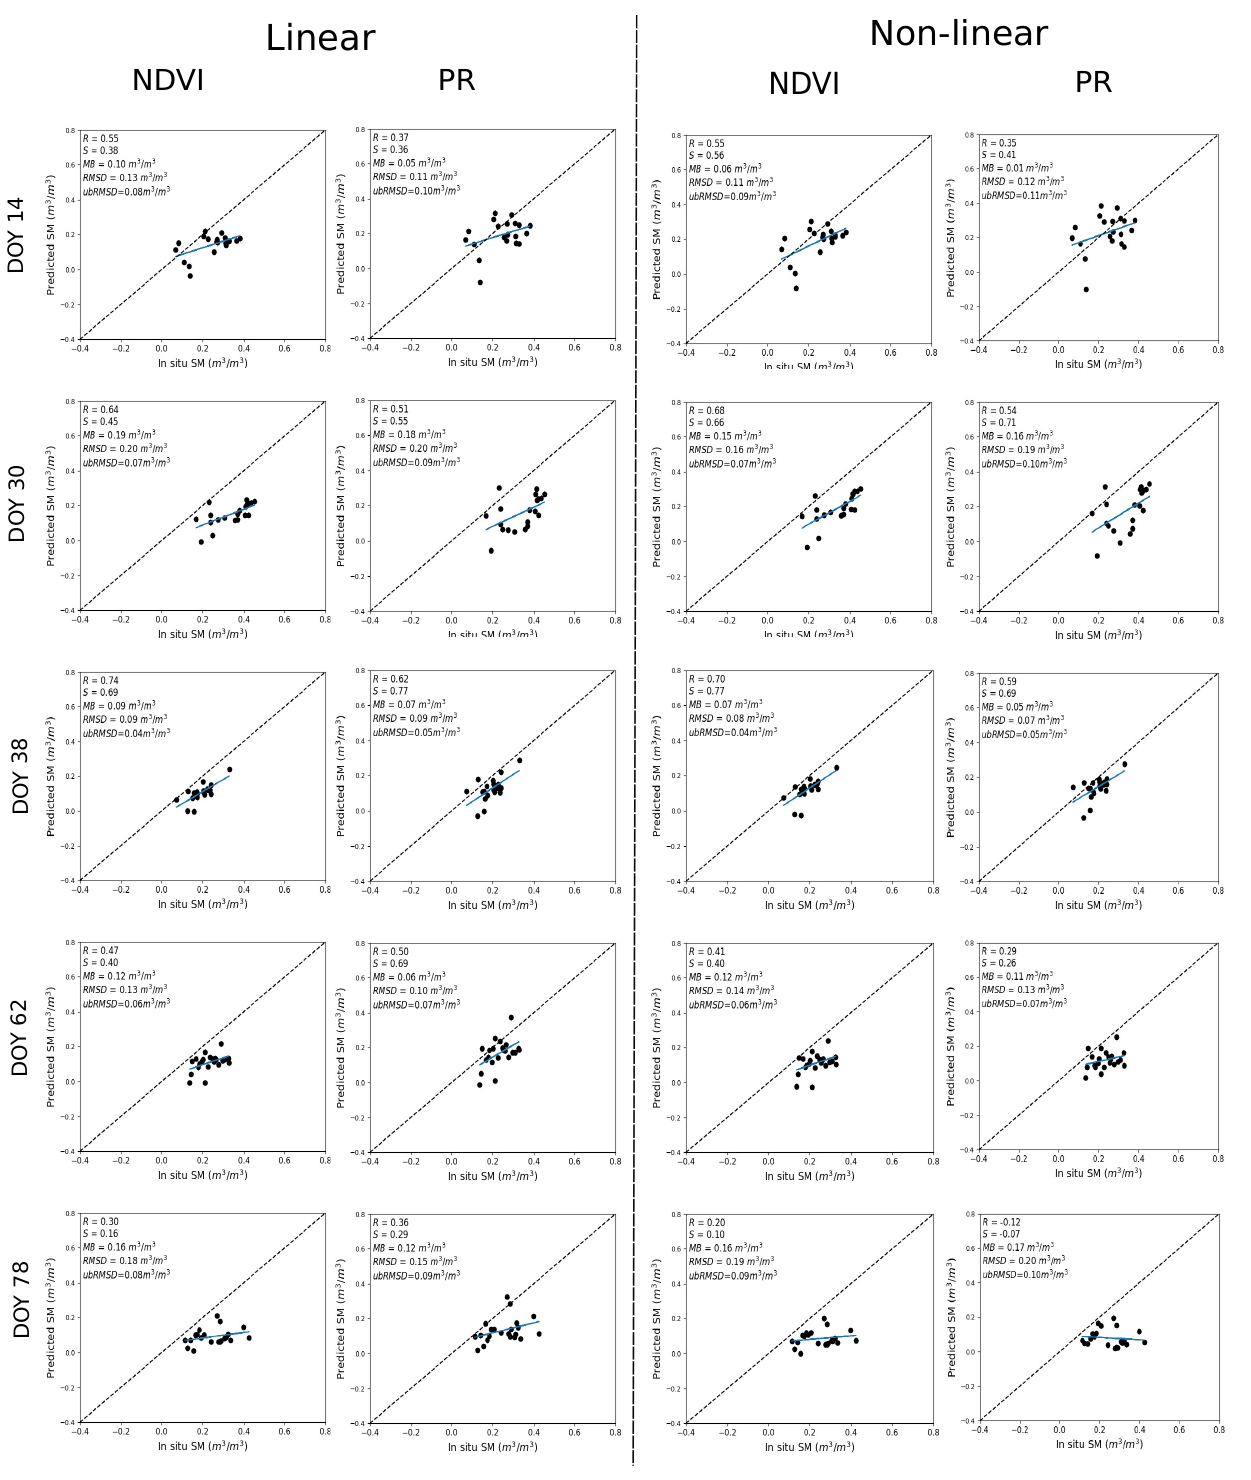
Figure 8. Same as Figure 6 but with DISPATCH SM data used for